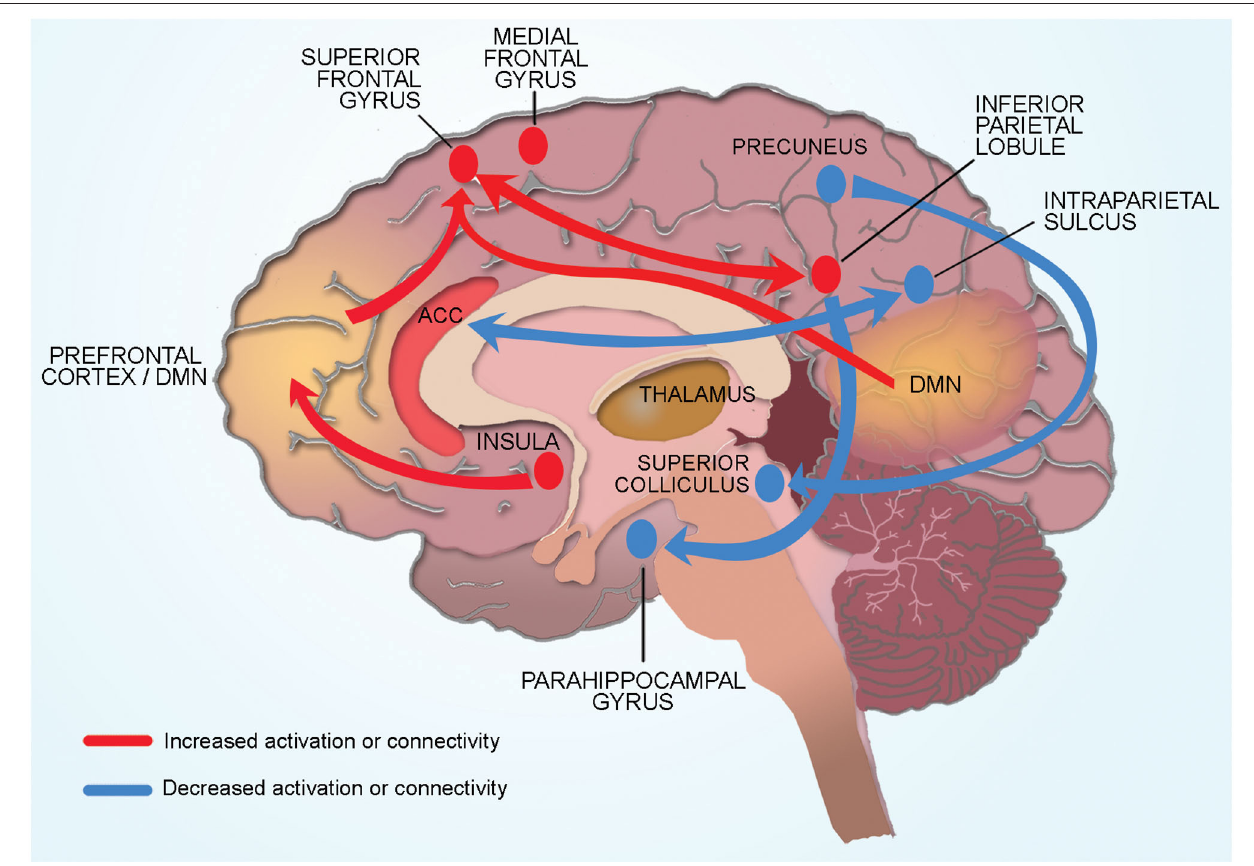
FIGURE 2 | Conceptual model of neural mechanisms of CRF. Cancer related fatigue is associated with compensatory hyper activation of multiple cortical regions involved in memory and planning (dorsomedial pre-frontal cortex, medial frontal gyrus, inferior parietal cortex). Connectivity changes in cortical and subcortical regions also contribute to CRF. Physical fatigue is associated with increased connectivity between the left inferior parietal lobule and superior frontal gyrus (region associated with memory and cognition). Increased connectivity of the default mode network to the superior frontal gyrus increases self-referential thoughts and a sensation of mental fatigue. Increased connectivity of the insula (processes internal body signals) to the dorsolateral pre-frontal cortex may lead to greater self-referential appraisal of fatigue. Reduced connectivity between the salience network (anterior cingulate cortex) and the dorsal attention network (intraparietal sulcus) contribute to CRF through hypervigilance of internal bodily signals and reduced engagement with the external environment. Subcortical structures such as superior colliculus and pulvinar (thalamus) contribute indirectly to CRF by affecting sleep and alertness. Connectivity of the right precuneus to the superior colliculus (sleep regulation) and of the inferior parietal lobule to parahippocampal gyrus (memory encoding and retrieval) may be protective against the development of